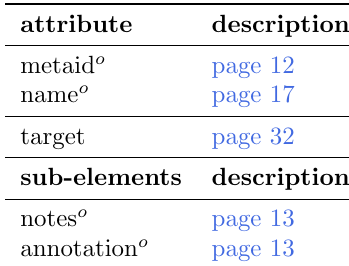
Table 2.10: Attributes and nested elements for change. o denotes optional elements and attributes.